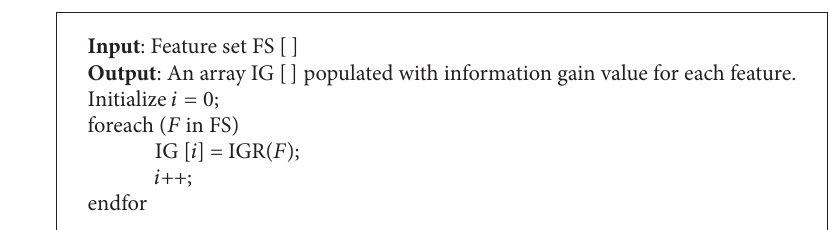
Algorithm 1: Information gain calculation.